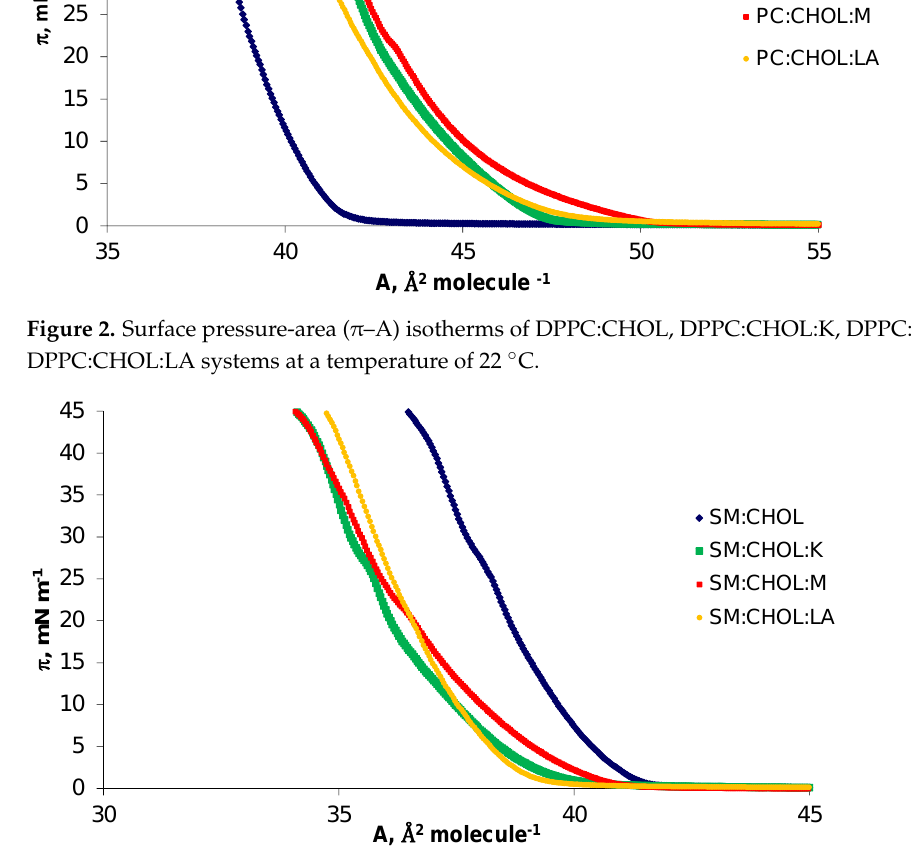
Figure 3. Surface pressure-area ( π –A) isotherms of SM:CHOL, SM:CHOL:K, SM:CHOL:M, SM:CHOL:LA systems at a temperature of 22 °C.